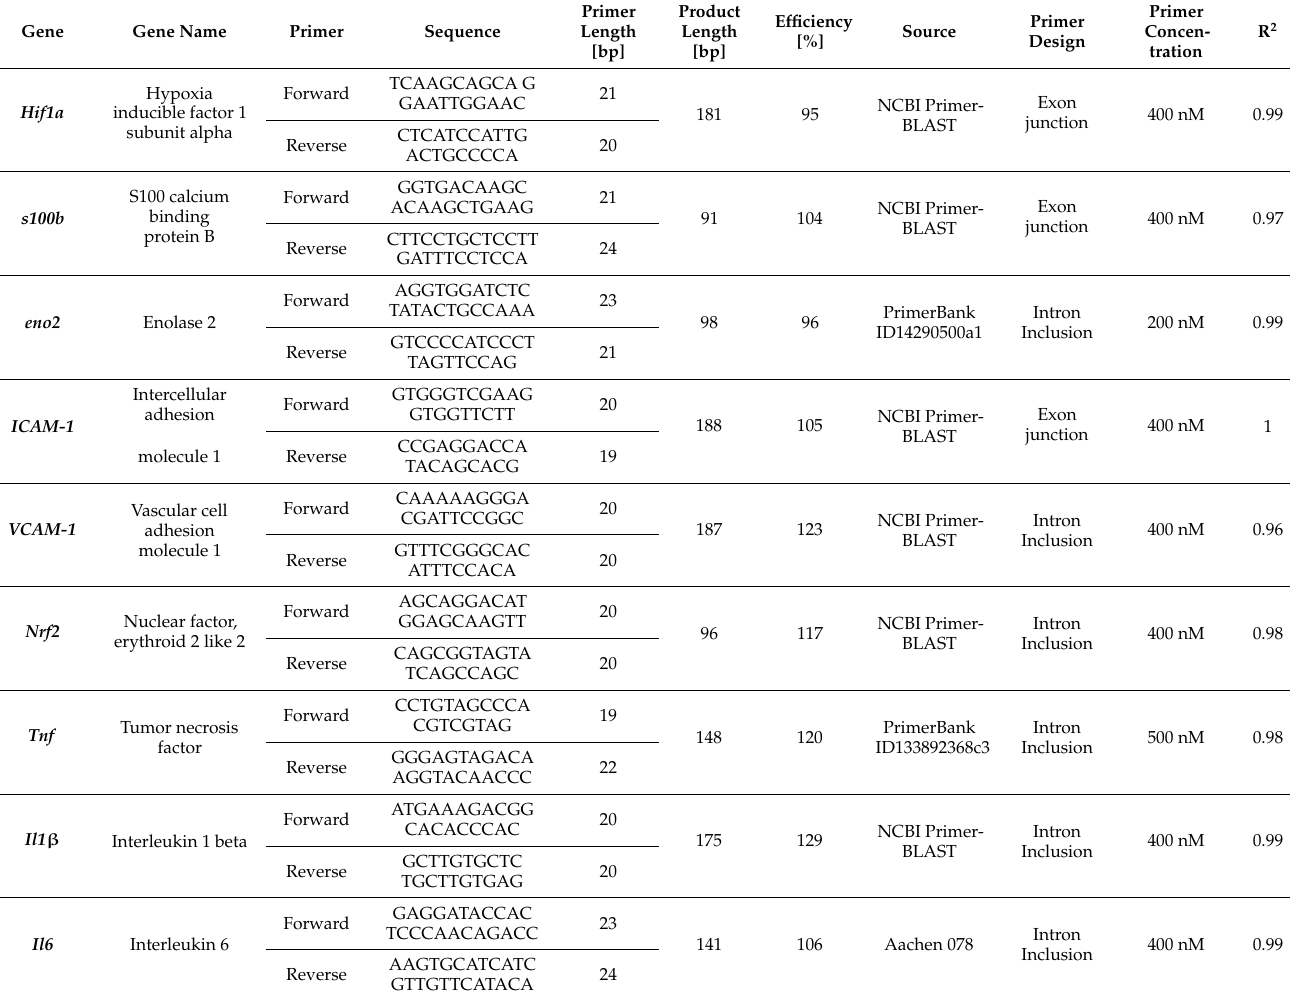
Table A1. List of qPCR-Primers. The primers used for the normalization are highlighted in